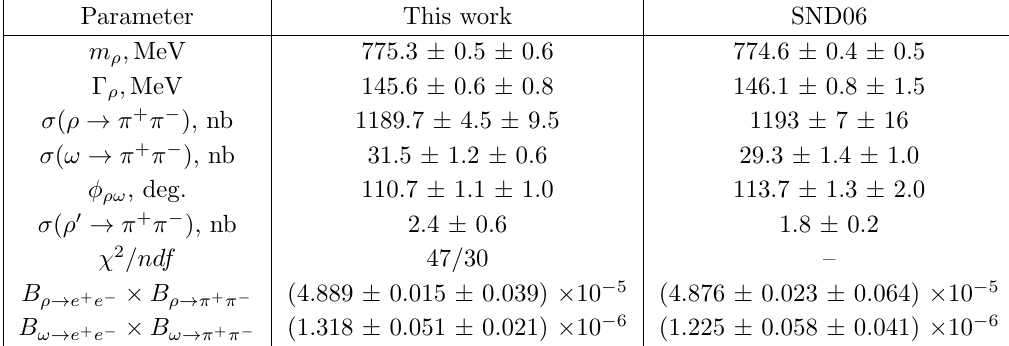
Table 3 . Results of the (cid:12)t obtained in this work together with results from ref. [26] (SND06). Both statistical and systematic errors are